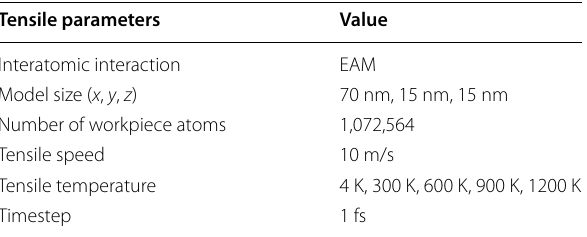
Table 1 Tensile simulation